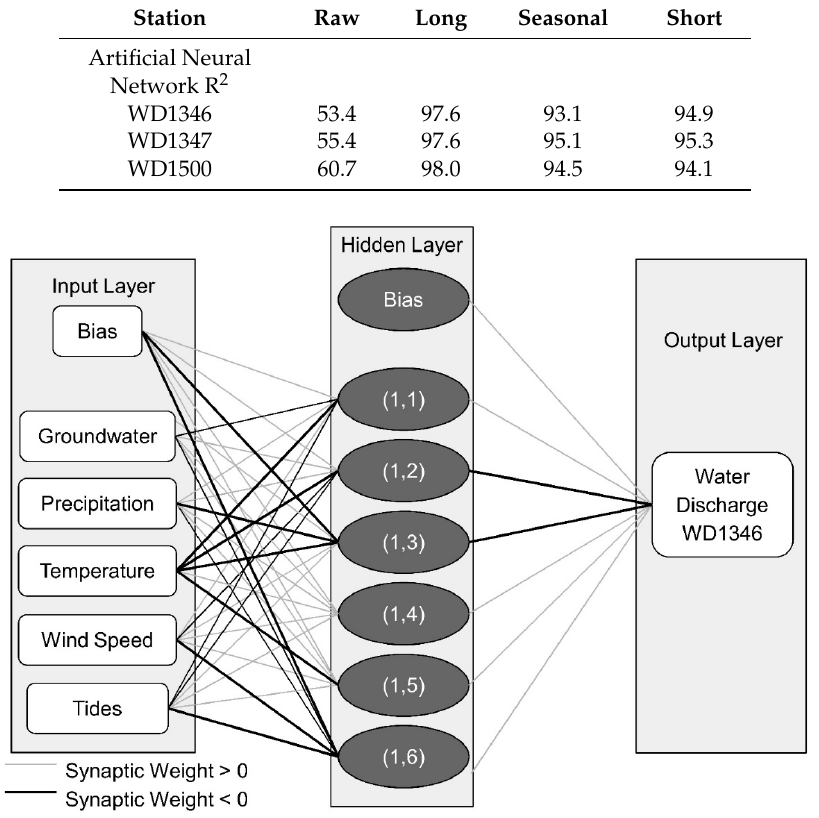
Table 2. Coefficient of determination (R 2 ) of the raw and decomposed data for the explanation of the water discharge time series using ANN model.